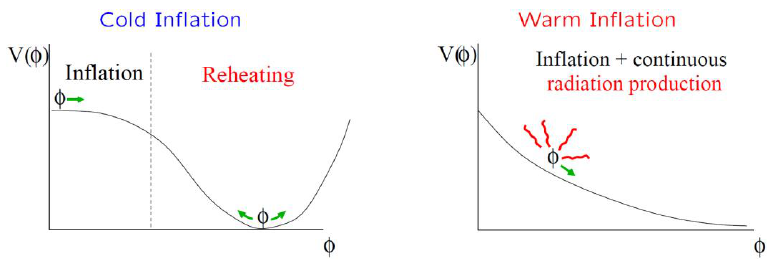
Figure 1. Illustration of the difference between cold inflation and warm inflation (Berera et al. (2009)).